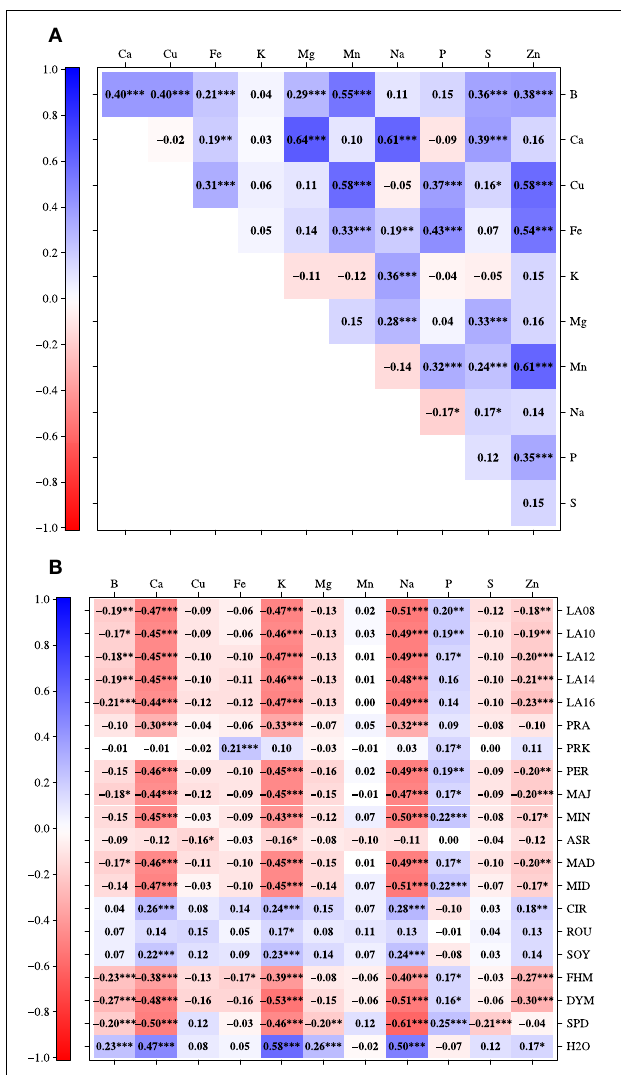
FIGURE 3 | Pearson correlation coefficients ( ∗ P ≤ 0.05, ∗∗ P ≤ 0.01, ∗∗∗ P ≤ 0.001, corrected using Holm’s method) between pairs of eleven different mineral concentrations in 509 B. napus inbreds (A) and between pairs of mineral concentrations and seedling development traits